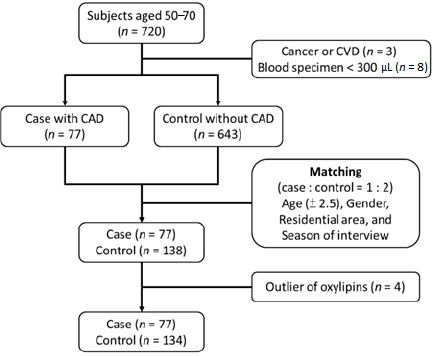
Figure 2. Study design flow chart of the nested case-control study on coronary artery